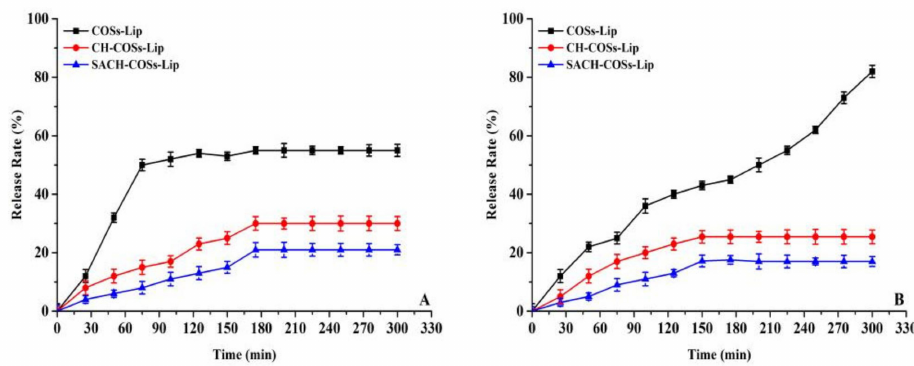
Figure 7. Release rate of COSs from COSs nano-liposomes during simulated intestinal digestion. ( A ) Simulated gastric digestion. ( B ) Simulated intestinal